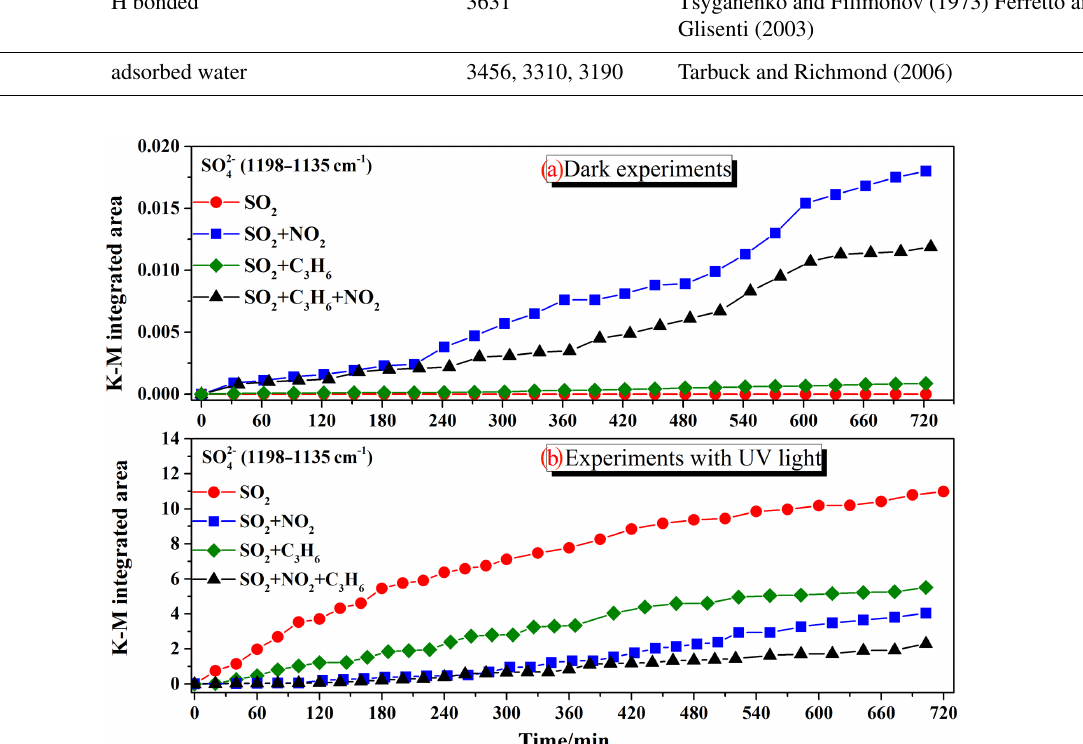
Figure 2. Integrated absorbance of the sulfate band (1198–1135cm − 1 ) observed during the reaction of 200ppbSO 2 , 200ppbSO 2 + 200ppbNO 2 , 200ppbSO 2 + 200ppb C 3 H 6 , 200ppbSO 2 + 200ppbNO 2 + 200ppbC 3 H 6 in dark experiments (a) and experiments with UV–Vis light (b)